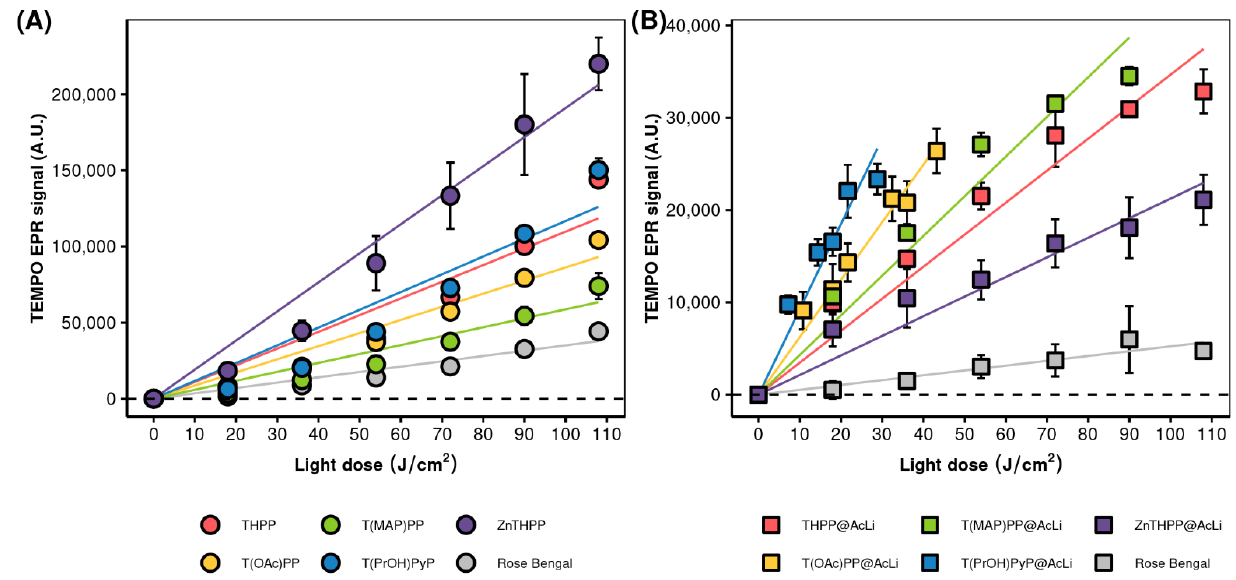
Figure 3. Singlet oxygen production, detected as TEMPO formation through EPR for ( A ) free porphyrins and ( B ) encapsulated porphyrins, using 12.5 mM of TEMP, either in DMF or in PB pH 7. Free porphyrins were dissolved in DMF, for a final concentration of 1.5 µM, while encapsulated porphyrins were suspended in PB pH 7, at 25 µM of their corresponding porphyrin. Rose Bengal was used as a standard, at ( A ) 1.5 µM and ( B ) 5 µM. The samples were irradiated with blue LED-light (450–460 nm, 60 mW/cm 2 ), at different light doses. The results shown are the average of three independent experiments. Table 4. Singlet oxygen quantum yield for the free porphyrins, calculated through the decay of singlet oxygen phosphorescence at 1270